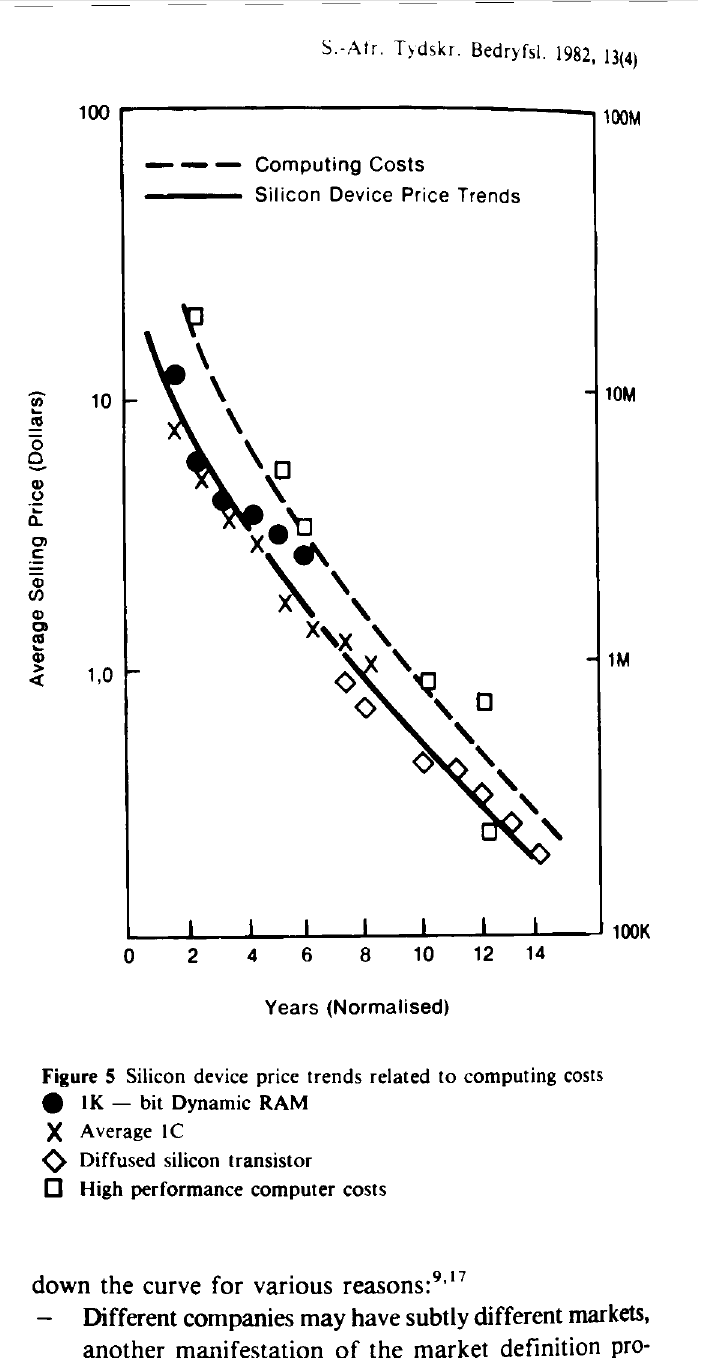
Figure S Silicon device price trends related to computing